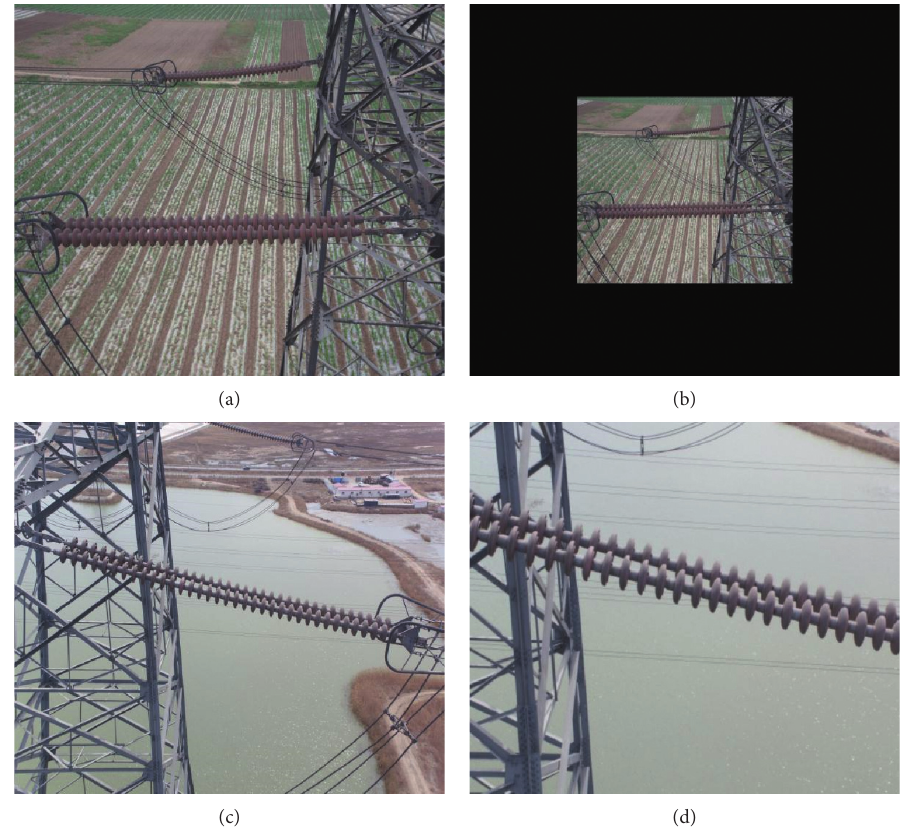
Figure 5: Images before and after